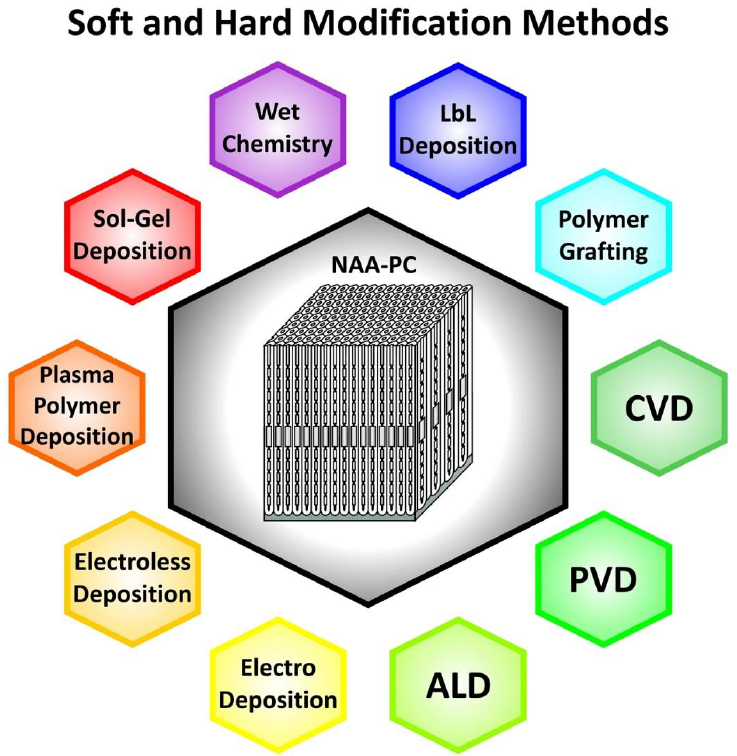
Figure 7. Soft and hard deposition methods used to modify the physical and chemical properties of